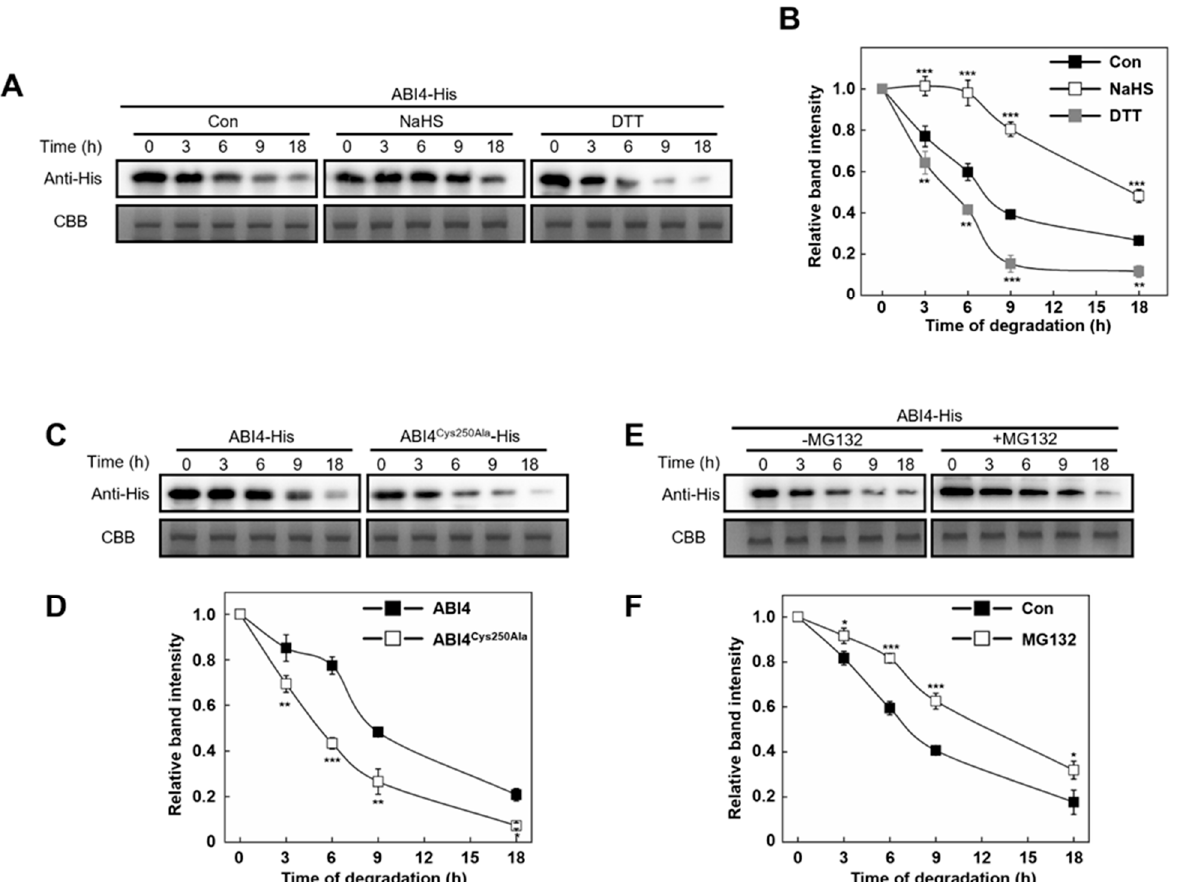
Figure 4. Persulfidation at Cys250 of ABI4 inhibits its degradation In vitro. ( A ) Cell-free degradation of ABI4-His recombinant protein in protein extracts from Col-0. Purified ABI4-His recombinant pro- tein was treated with NaHS (0.1 mM) or DTT (1 mM) for 1 h, dialyzed, and then incubated with extracts of 10-day-old Arabidopsis seedlings at 25 ° C. Protein without chemical treatment was set as control (Con). During incubation, samples were collected at indicated time points for immunoblot analysis using anti-His antibody. Samples collected before the addition of protein extracts were set as internal control, as normalized to load equal amounts determined by Coomassie brilliant blue staining (CCB). ( B ) Quantification of the relative band intensity shown in ( A ). ( C ) Cell-free degra- dation analysis of ABI4 mutant recombinant proteins. Purified ABI4-His and ABI4 Cys250Ala -His re- combinant protein were dialyzed and then incubated with extracts of 10-day-old Arabidopsis seed- lings. Sample treatments and measurements were as described for ( A ). ( D ) Quantification of the relative band intensity shown in ( C ). ( E ) The effect of MG132 on the stability of ABI4 in vitro. Puri- fied ABI4-His recombinant proteins were dialyzed and then incubated with extracts containing 50